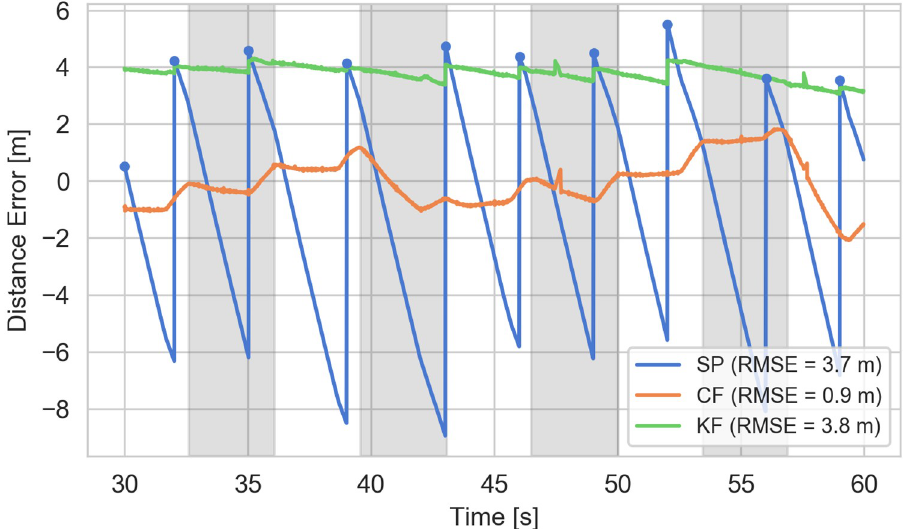
Fig 12. Example boat distance estimate errors. Error in the smartphone, complementary filter, and Kalman filter distance estimates relative to the DGPS for the last 30 s of the elite 16NW trial. The “saw-tooth” smartphone error curve is derived from the piece-wise constant curve shown in Fig 11 to highlight the issue it poses when one desires to calculate distance per stroke. The alternating gray and white sections indicate each stroke. The RMSE values are the same as in Fig 11.